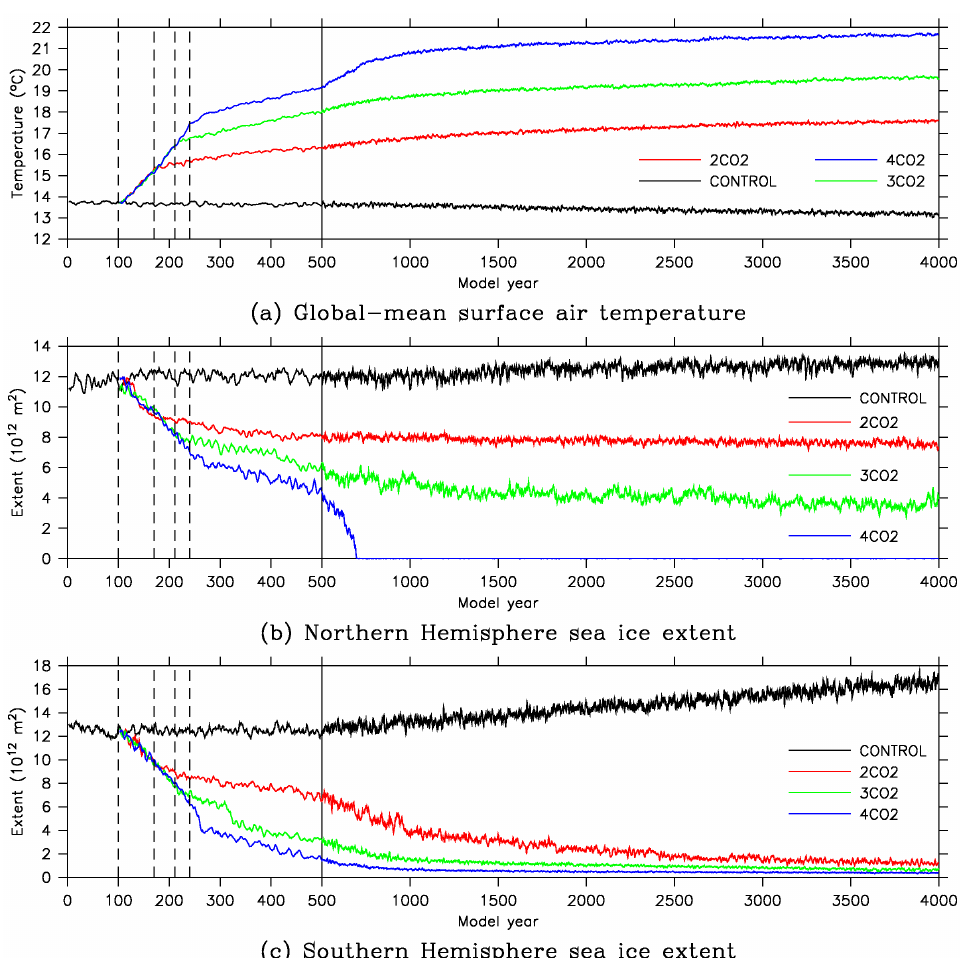
Fig. 19. The changes in annual-mean surface air temperature and sea ice extent during experiments CONTROL (black), 2CO2 (red), 3CO2 (green) and 4CO2 (blue): (a) the global-mean surface air temperature, (b) the Northern Hemisphere sea ice extent, and (c) the Southern Hemisphere sea ice extent. The values shown are five-year running means. Vertical dashed lines indicate model years 100, 170, 211 and 240. Note the change in the scale of the time axis at year